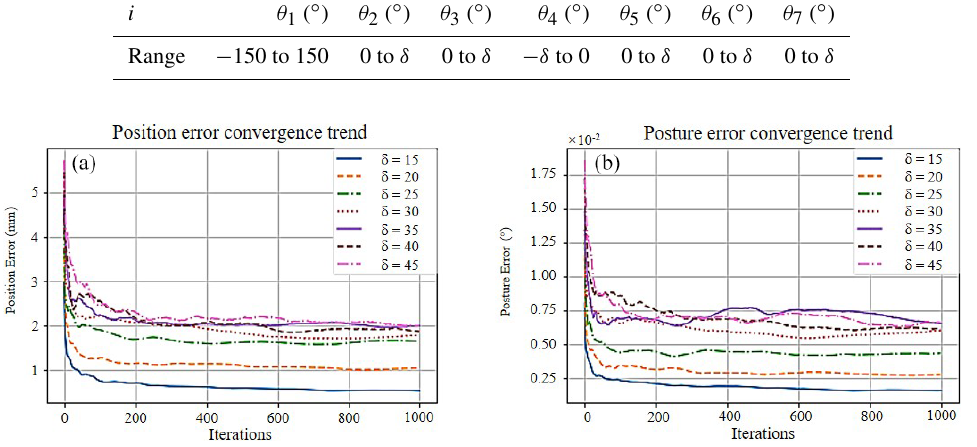
Figure 6. (a) Convergence plots of the position error. (b) Convergence plots of the posture error.